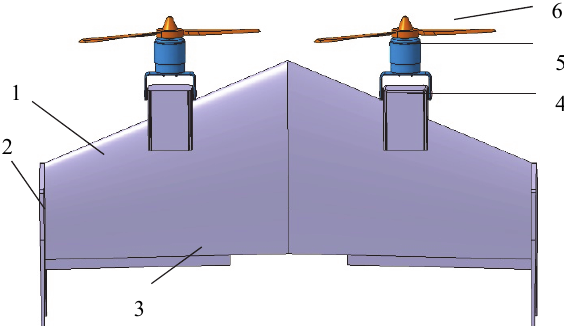
Figure 1. Tailsitter unmanned aerial vehicle (UAV) schematic. (1) wing; (2) winglet; (3) rudder surface; (4) motor seat; (5) motor; (6) propeller.